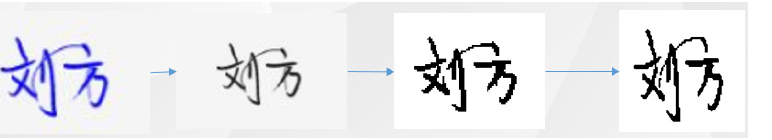
Figure 2. The pre-processing for offline image, from left to right are the original image, grayscale image, binary image and normalized image.